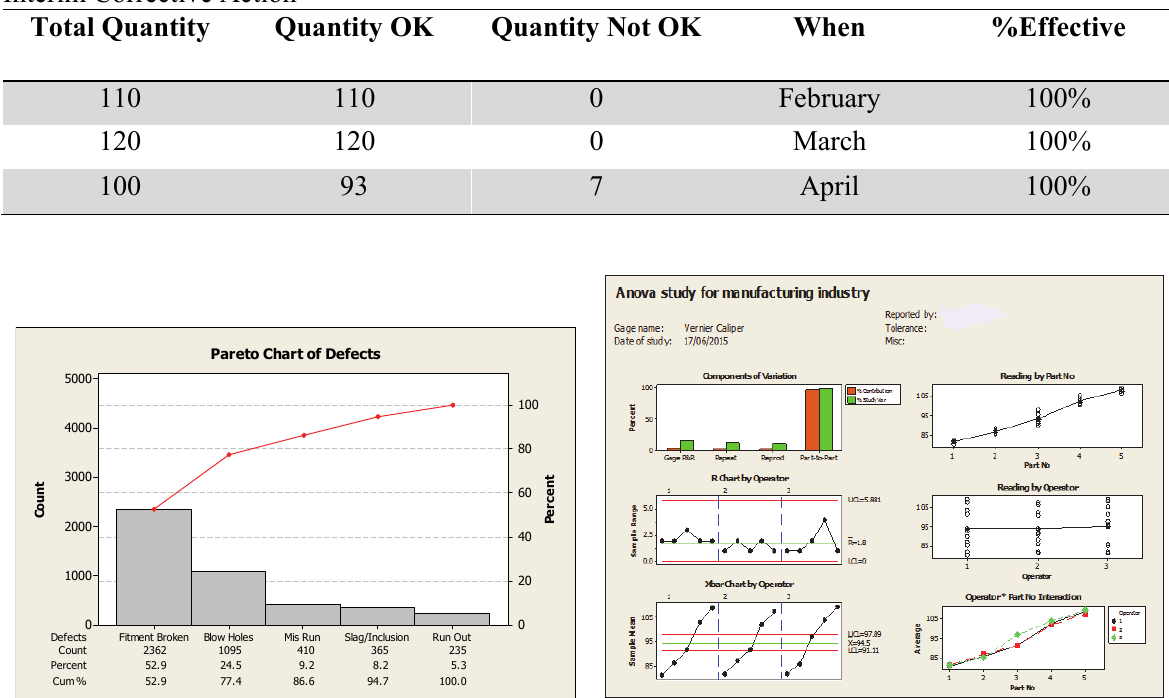
Fig. 2. Pareto Chart for Rejection Fig. 3. Measurement System